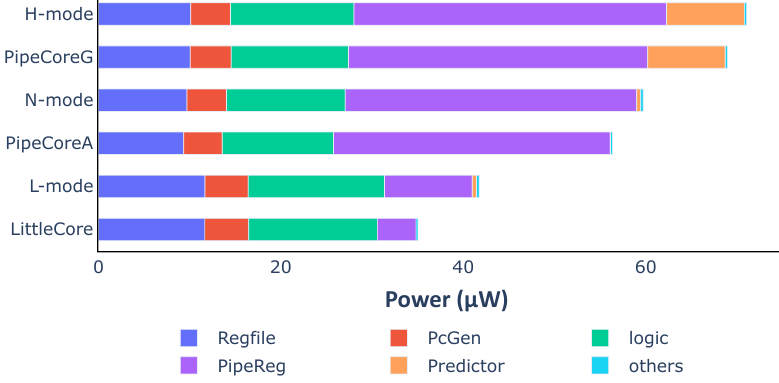
Figure 12. Average power consumption and distribution of the variable processor in different modes. Energy dissipation for each instruction is shown in Figure 13. To execute one in- struction, the variable core in different modes consumes 2.12 pJ (L-mode), 4.02 pJ (N- mode) and 4.50 pJ (H-mode), respectively. For each instruction, the variable core in L-mode needs 52.92% less energy than H-mode. Compared with PipeCoreG consuming 4.36 pJ/instruction, the variable core could save 7.78% and 51.57% more energy in N-mode and L-mode. Only 3.08% more power is consumed in H-mode. According to the power and energy distribution, shutting down the branch predictor saves 0.509 pJ energy which is 92.2% of total energy consumed by the Gshare predictor in PipeCoreG. Bypassing pipeline registers between Fetch and Execute saves 1.585 pJ energy. That is 76.48% of all pipeline registers in PipeCoreG. The energy overhead of H-mode, which is 0.134 pJ, is 3.08% of the total power in PipeCoreG. Most of the additional energy is caused by MUX logics after pipeline